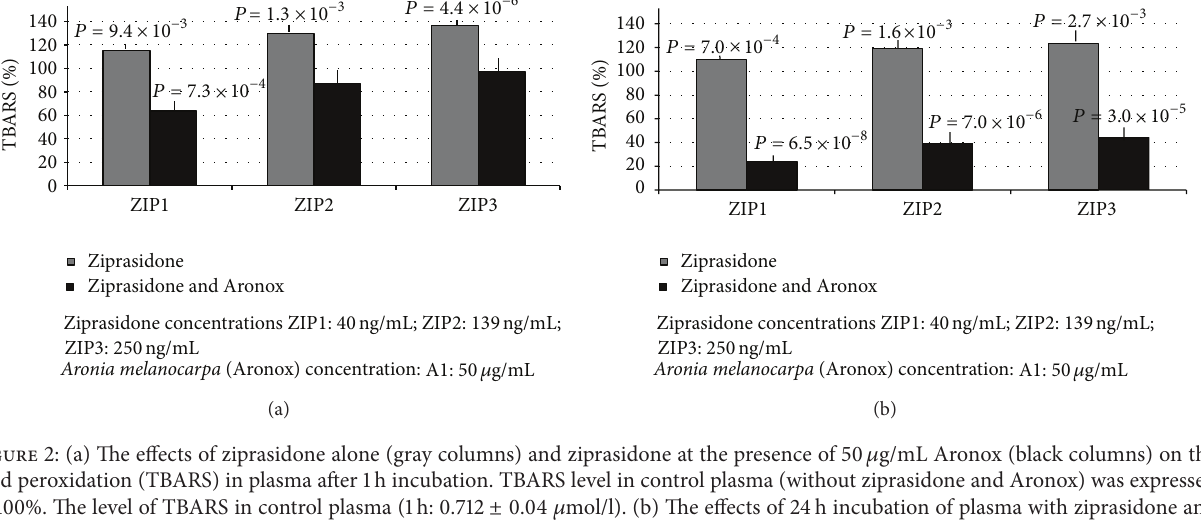
did not induce plasma lipid peroxidation in vitro [33,